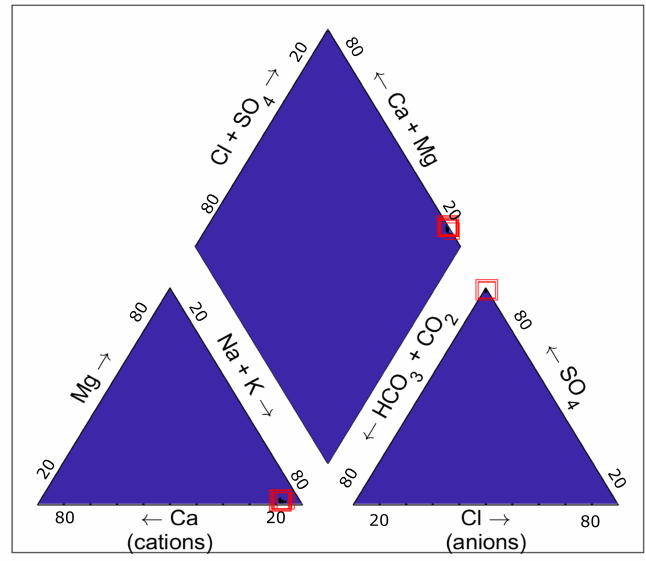
Figure 4. Piper diagram of reinjection Sønderborg brine. Made with [35] with information from